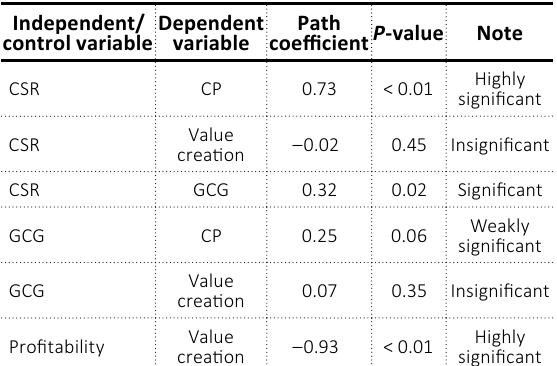
Table 7. Path coefficient and p -values